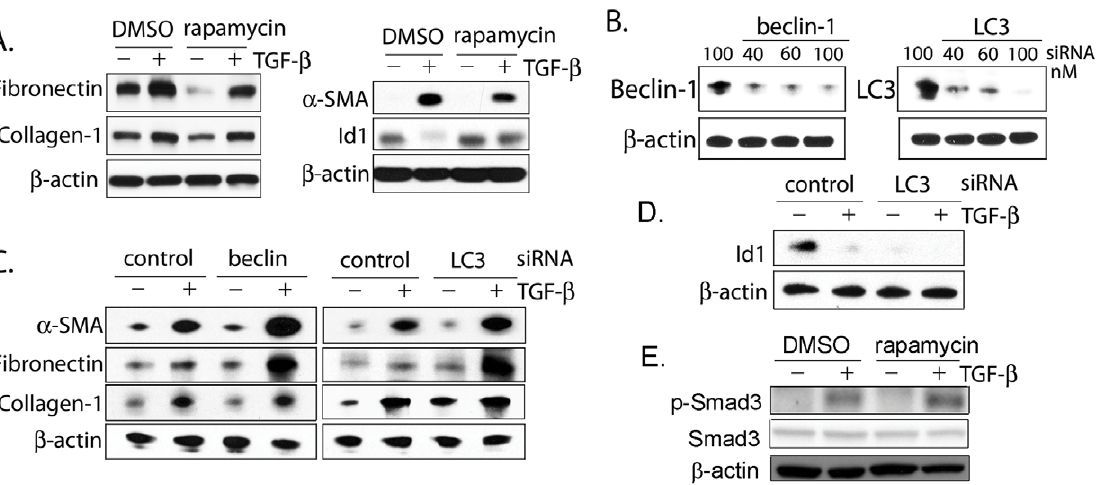
Figure 5. Inhibition of autophagy potentiates fibroblast activation. A) Rapamycin inhibits fibronectin and a -SMA expression in fibroblasts, and abrogates TGF- b 1 suppression of Id-1. B) Beclin and LC3 siRNA effectively inhibit protein expression. C) a -SMA and fibronectin expression increases in fibroblasts with beclin and LC3 silencing whereas collagen is unchanged. D) When LC3 is silenced, Id-1 expression is lower than control. E) Rapamycin does not modulate phosphorylation of Smad3 in response to TGF- b 1